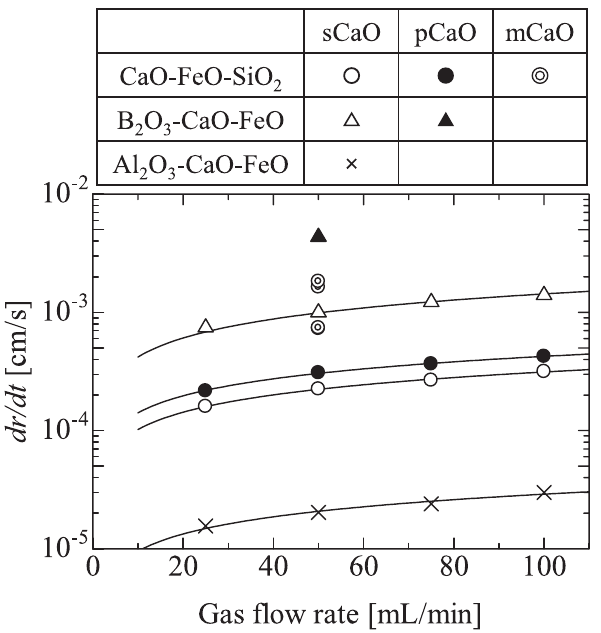
Fig. 16: The comparison of dissolution rate as a function of gas flow